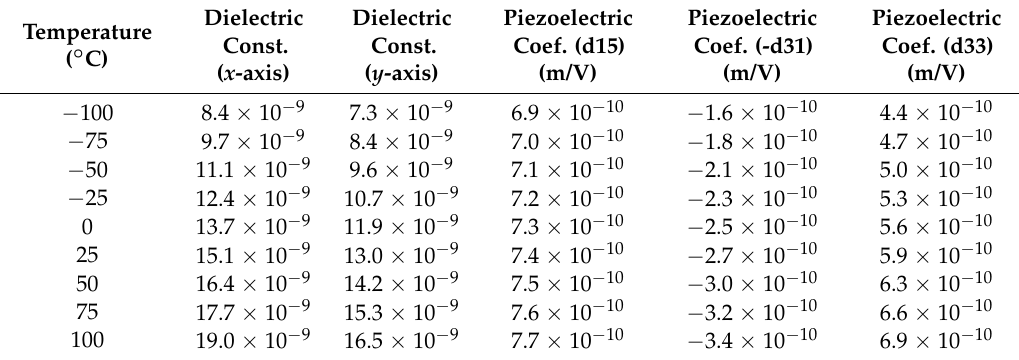
Table 2. Material properties of the PZT at various temperatures